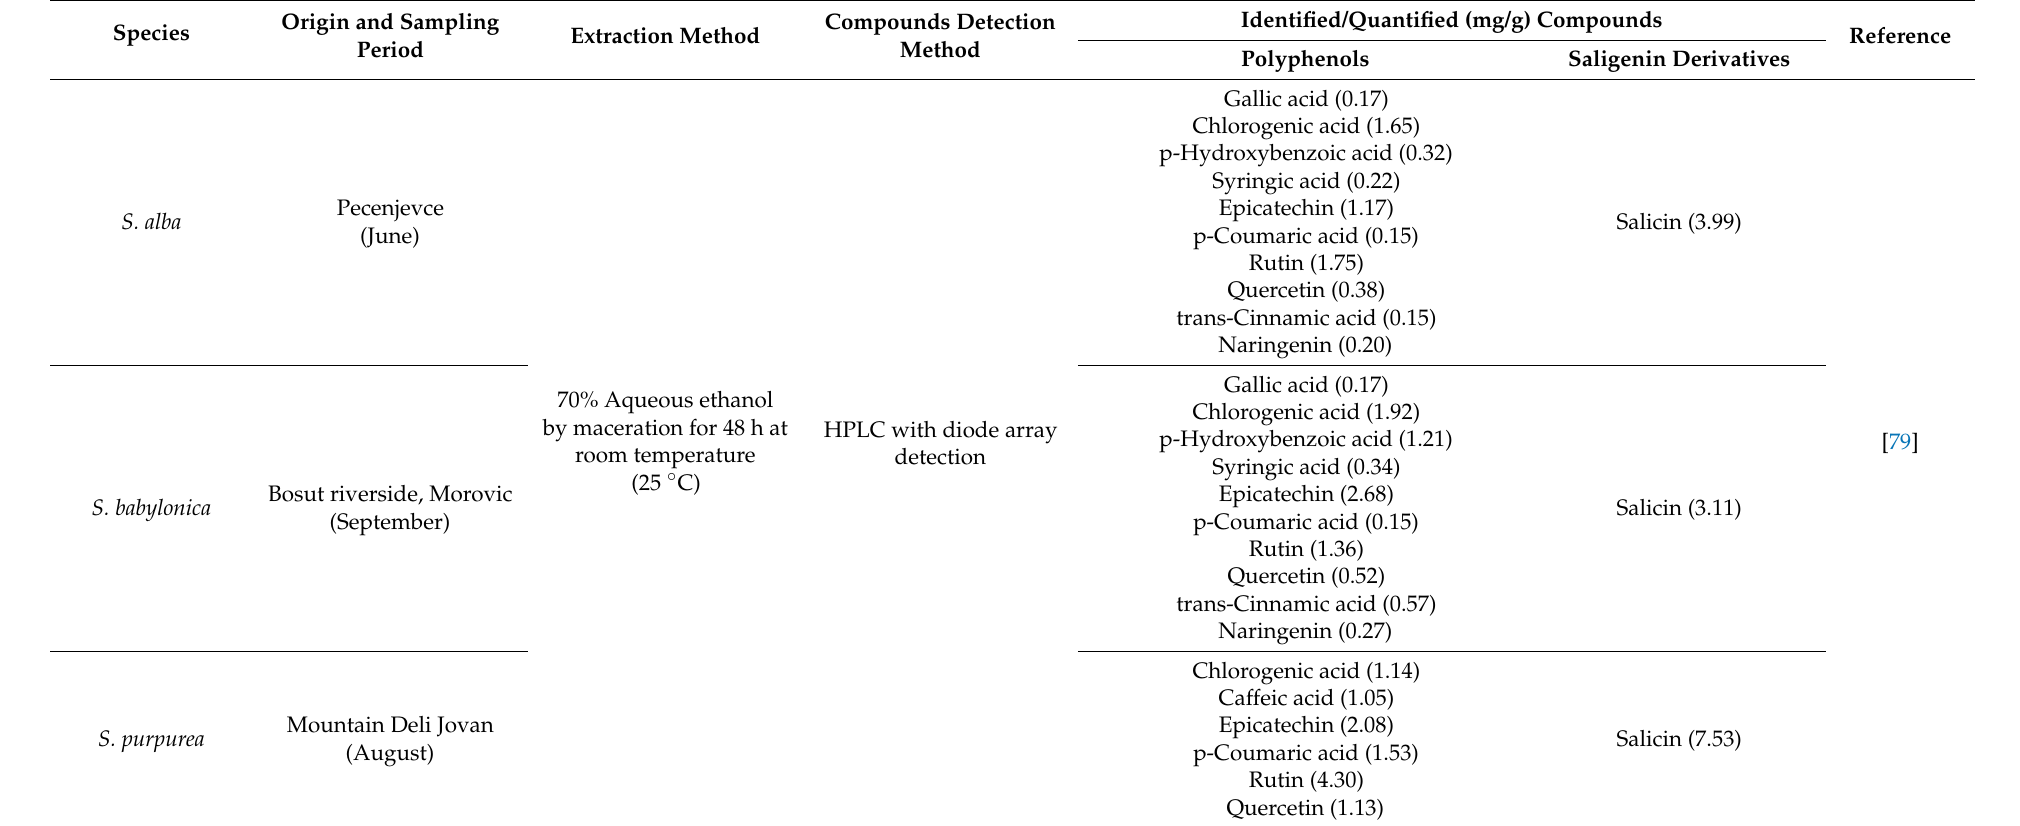
Table 1. Polyphenols and saligenin derivatives identified and/or quantified in different barks of Salix